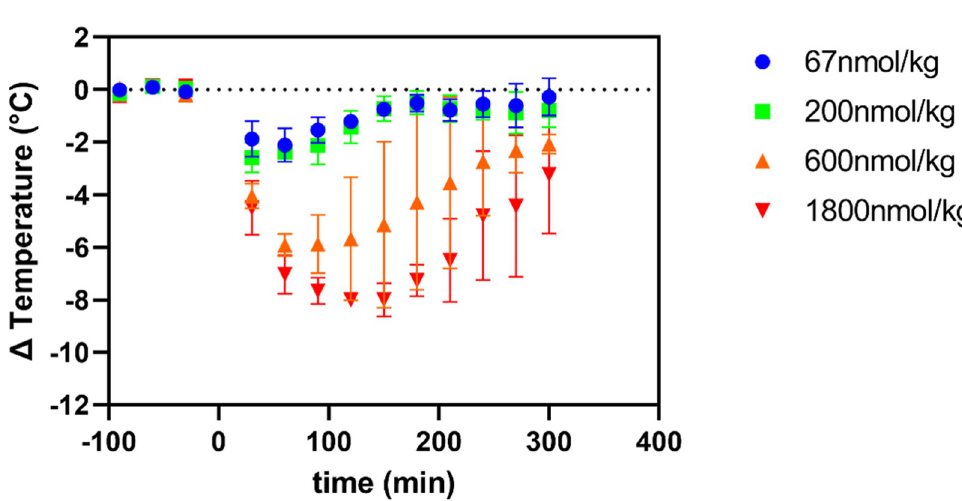
increased from 67nmol/kg body weight to 1800nmol/kg body